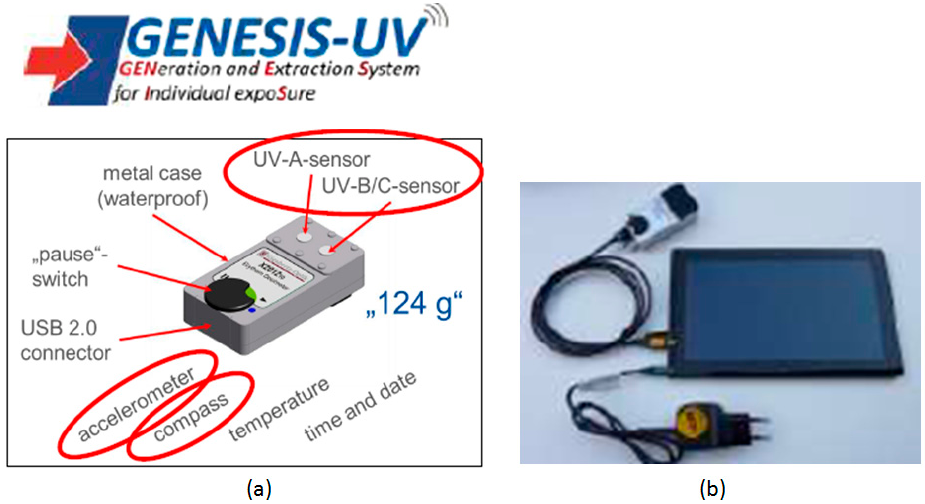
Figure 1. The GENESIS-UV system for long-term occupational UV exposure monitoring: ( a ) the electronic UV dosimeter X-2012-10 and its characteristics; ( b ) the dosimeter connected to a tablet PC.